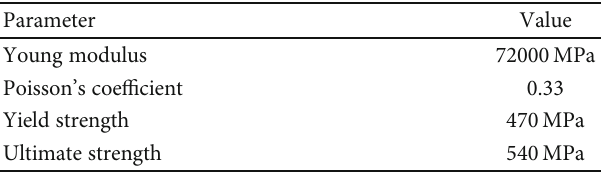
Table 4: Thickness distribution for the skin structural layer.